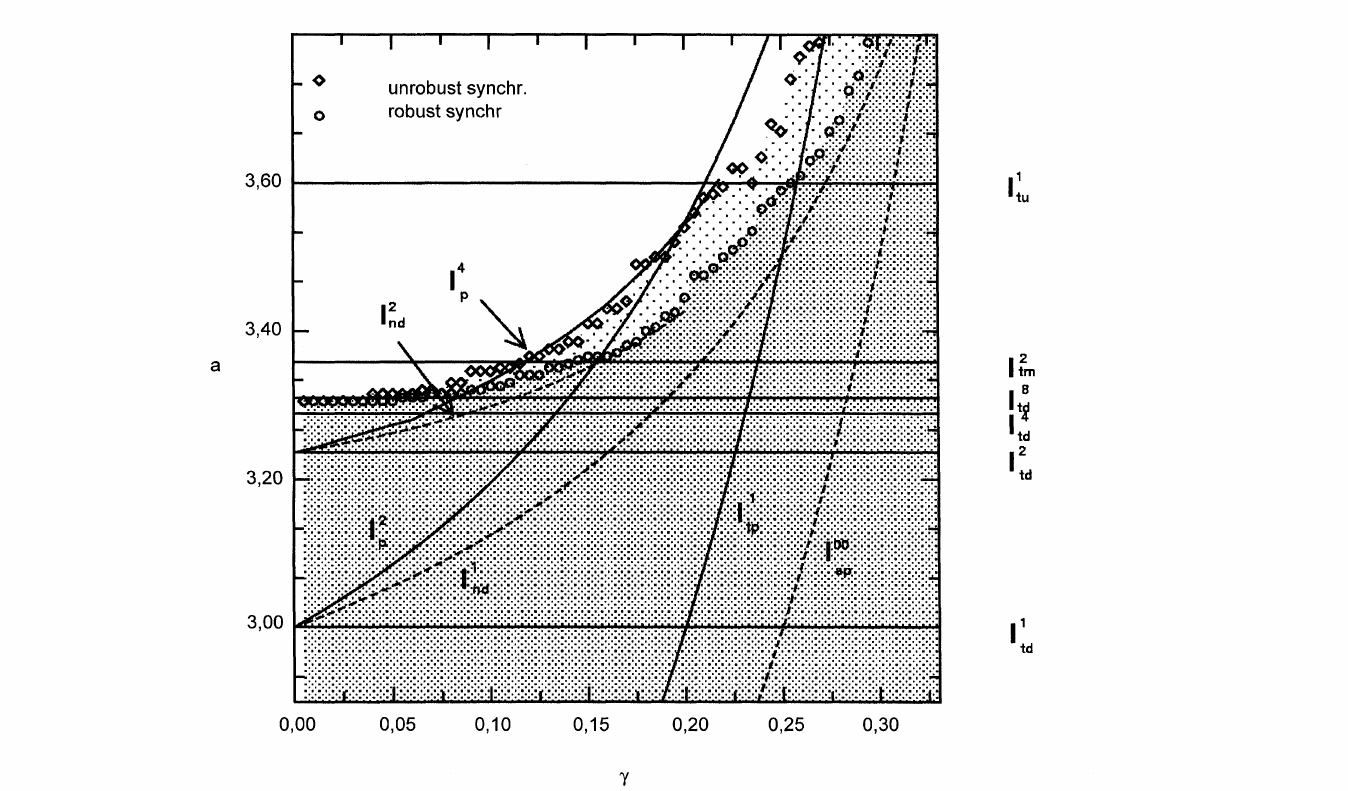
FIGURE Bifurcational lines of symmetric periodic orbits and boundaries of unrobust (o) and robust () in-phase synchroniz.ation of chaos on the pane of the parameters 3’-a. becomes equal to + (the pitchfork